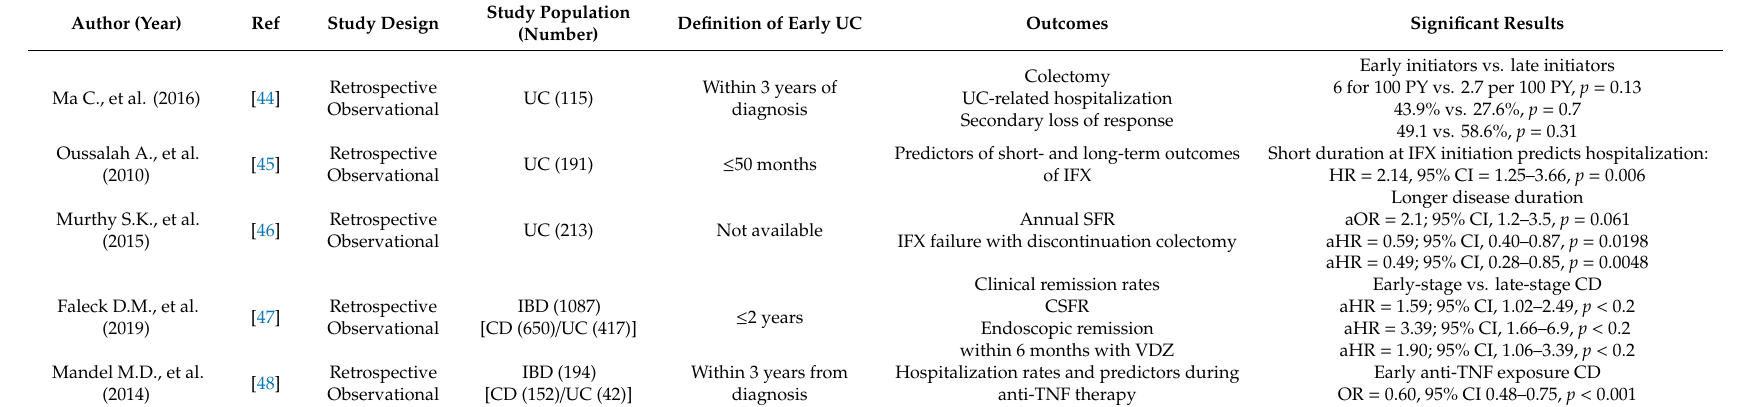
Table 1. List of relevant cohort studies on early treatment in